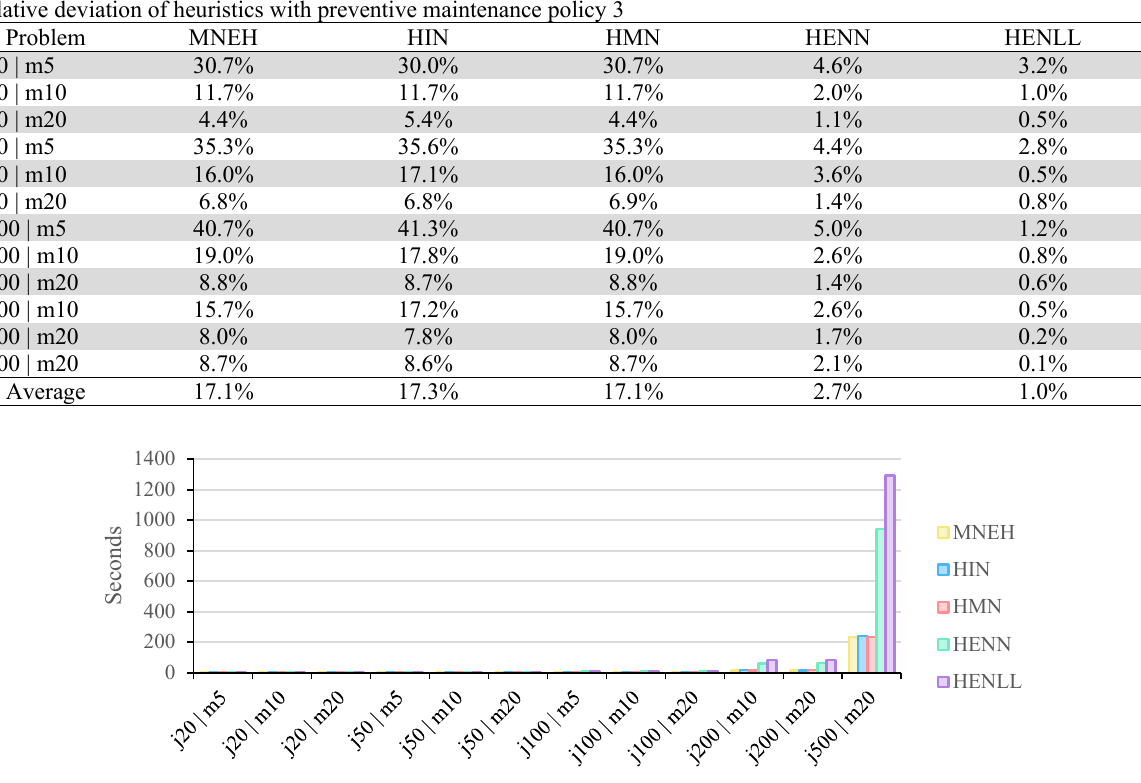
Fig. 7. Graphs of construction heuristics’ execution times with preventive maintenance policy 1